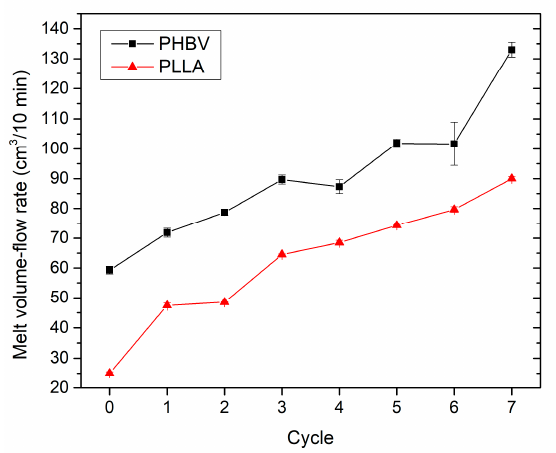
Figure 3. PLLA and PHBV melt volume flow rate as a function of recycling cycle.